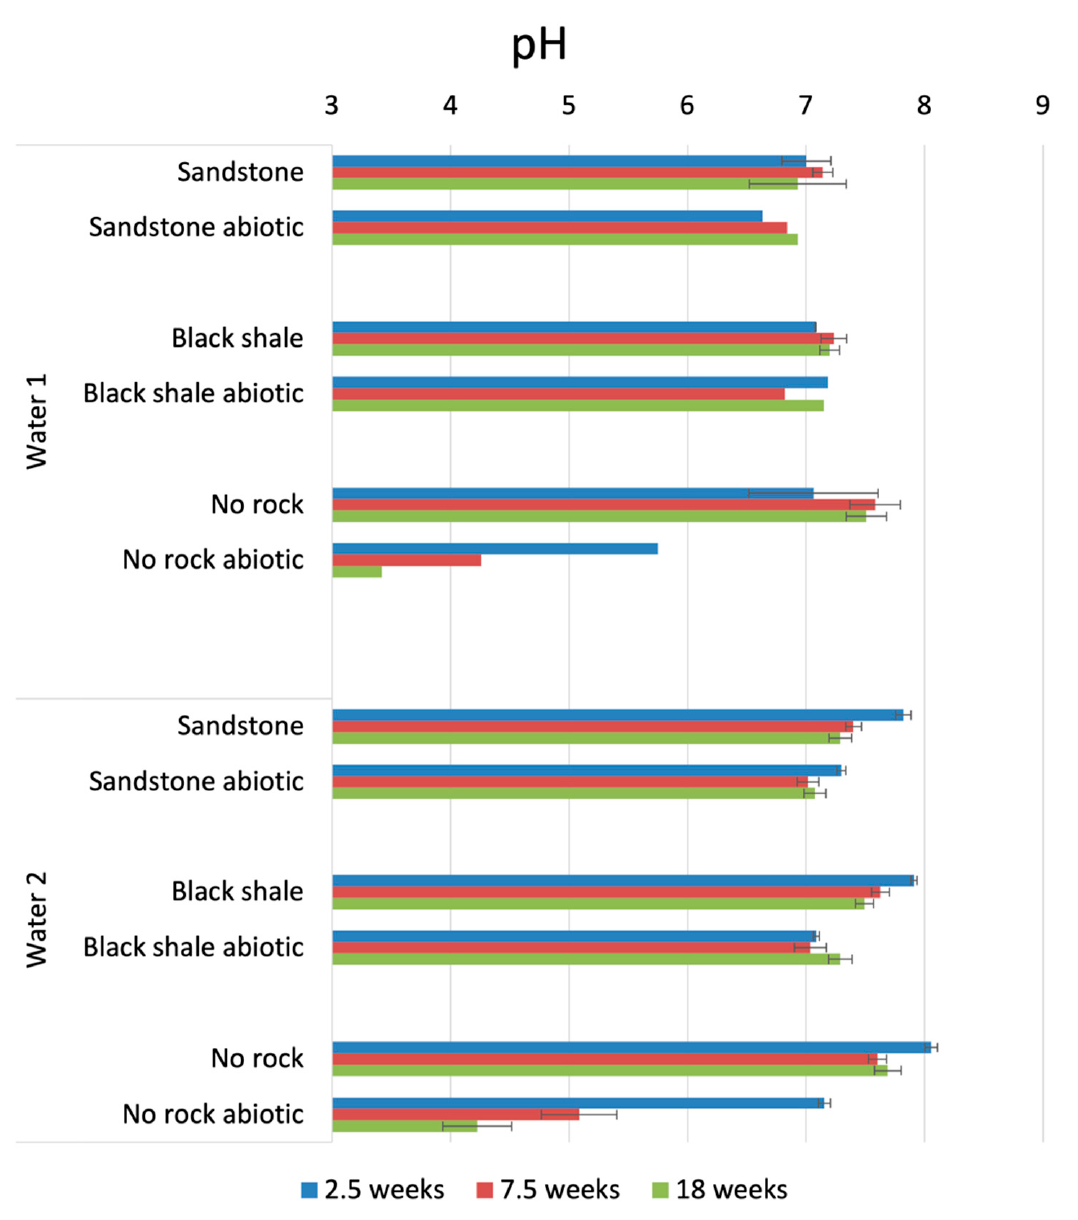
Figure 1. The average pH values in the water of the live and abiotic microcosms after 2.5, 7.5 and 18 weeks of incubation. Error bars indicate highest and lowest values of two microcosms. Abiotic controls for Water 1 show measurements of one microcosm each.